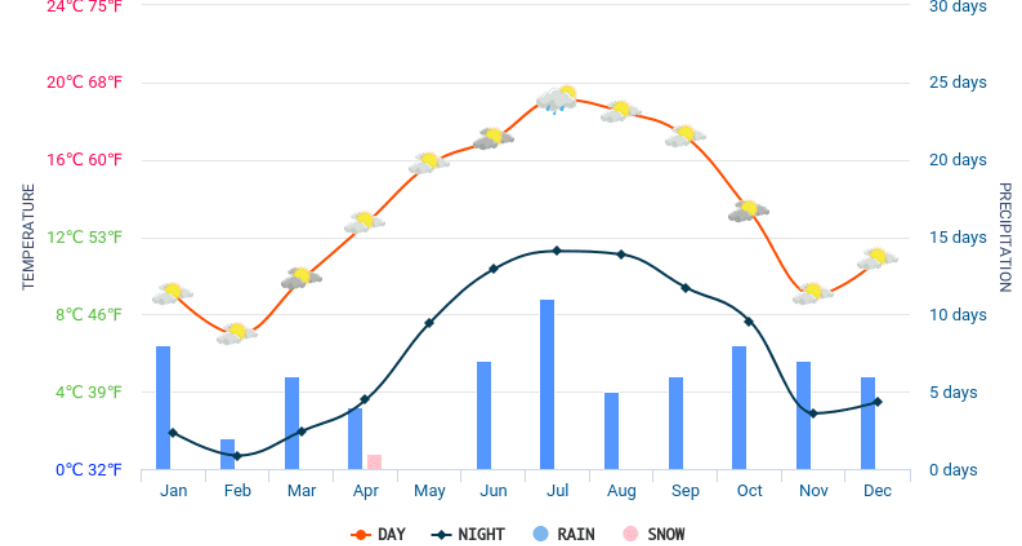
Figure 2. Dundee, Scotland weather (average monthly temperature and precipitation (rain and snow), and sunny and cloudy Days, 2015–2020) (source: hikersbay.com/climate/scotland/dundee (accessed: 25 September 2020)).